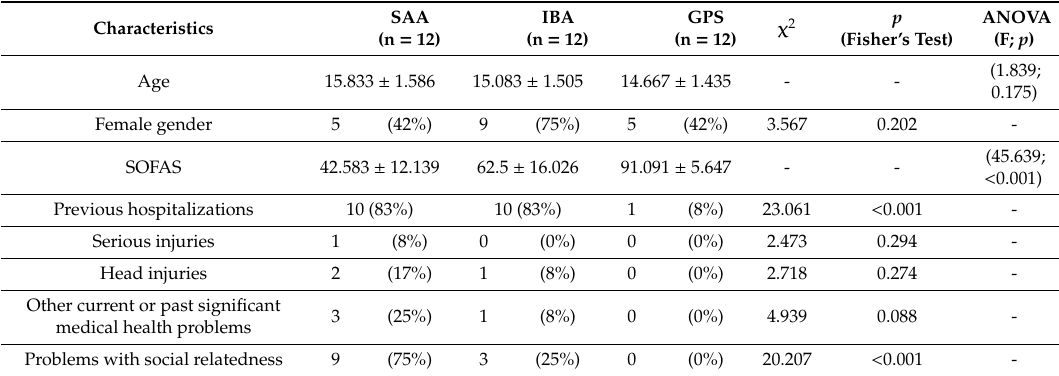
Table 1. Sociodemographic and clinical group characteristics (N =